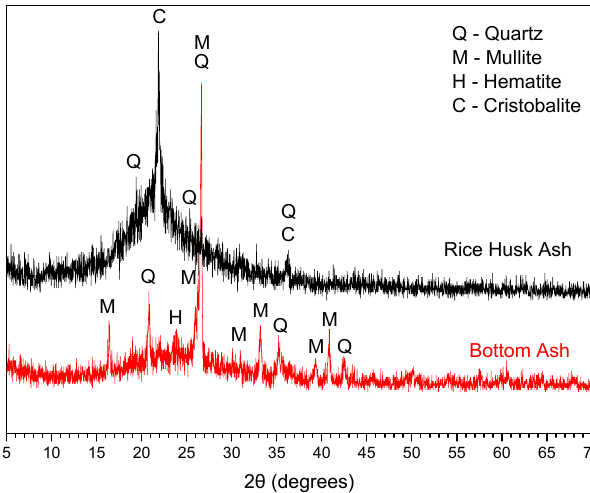
Figure 2. XRD patterns of bottom ash and rice husk ash. Materials 2018 , 11 , x FOR PEER REVIEW